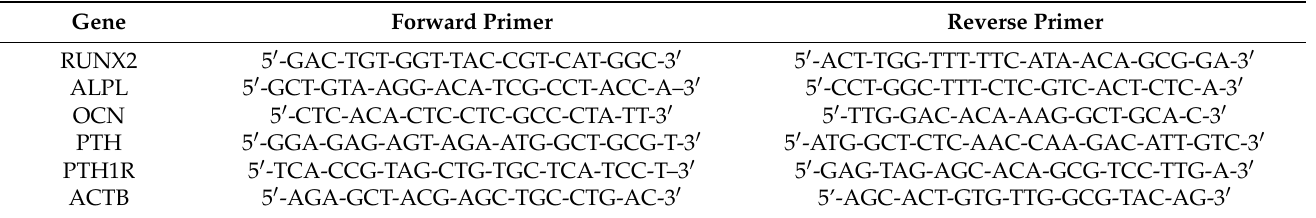
Table 1. List of